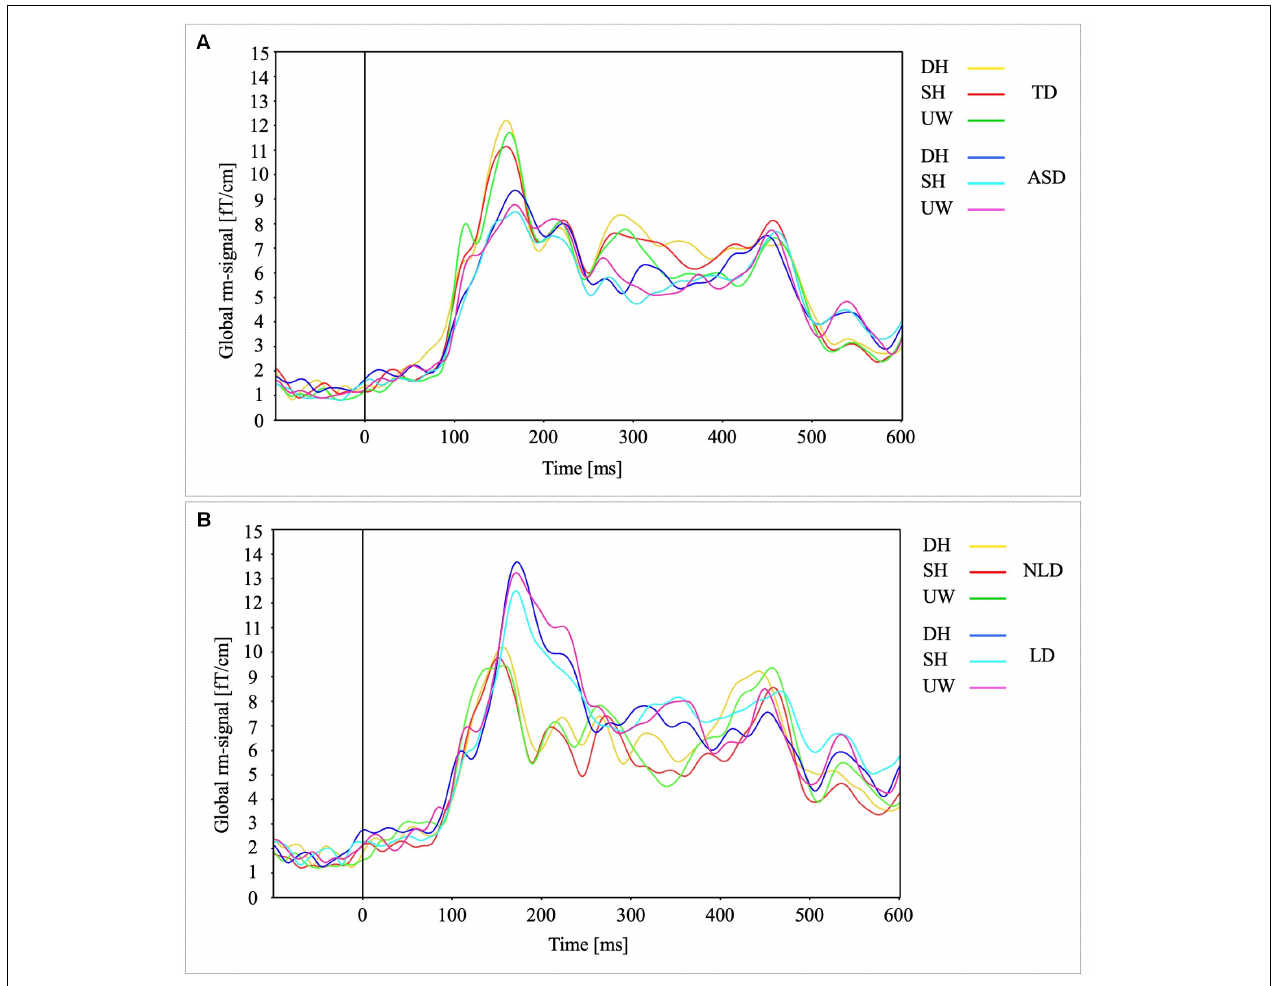
FIGURE 1 | (A) Global activations (RMS-curves) for three final words (dominant homonym, subordinate homonym, and unambiguous word) in TD and ASD groups. (B) Global activations (RMS-curves) for three final word conditions in NLD and LD